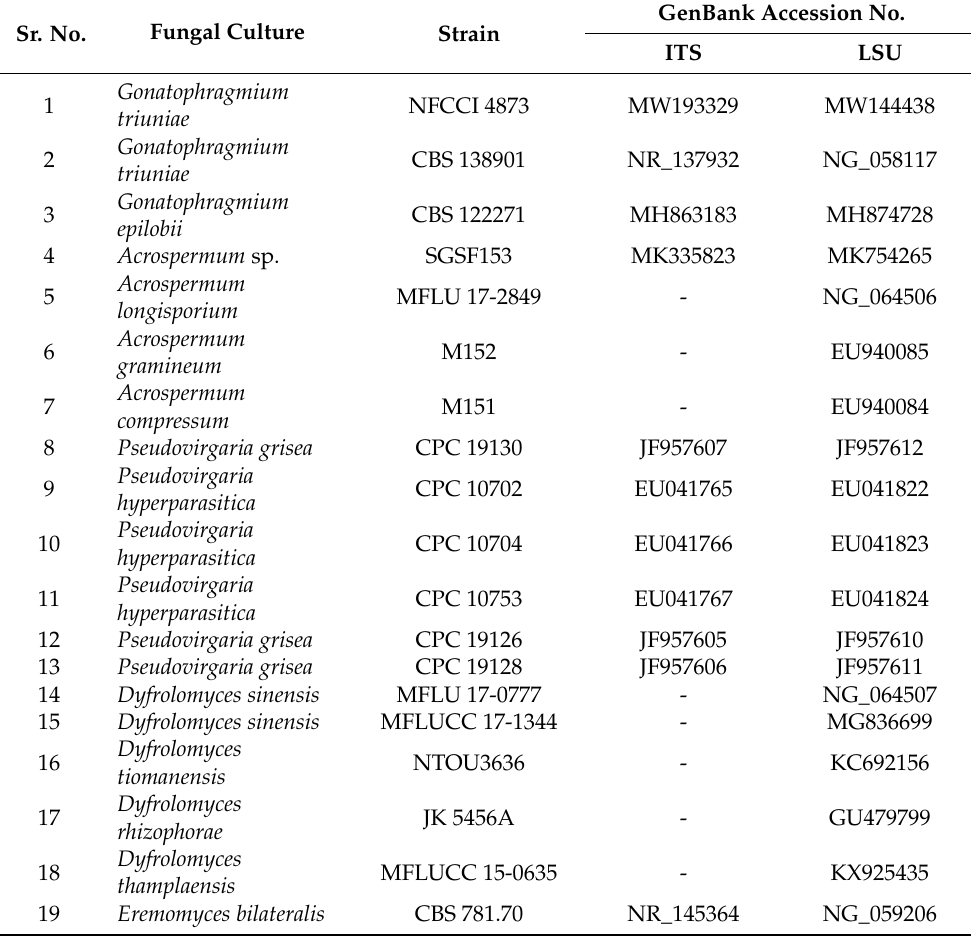
Table 4. GenBank accession numbers of taxa used for phylogenetic